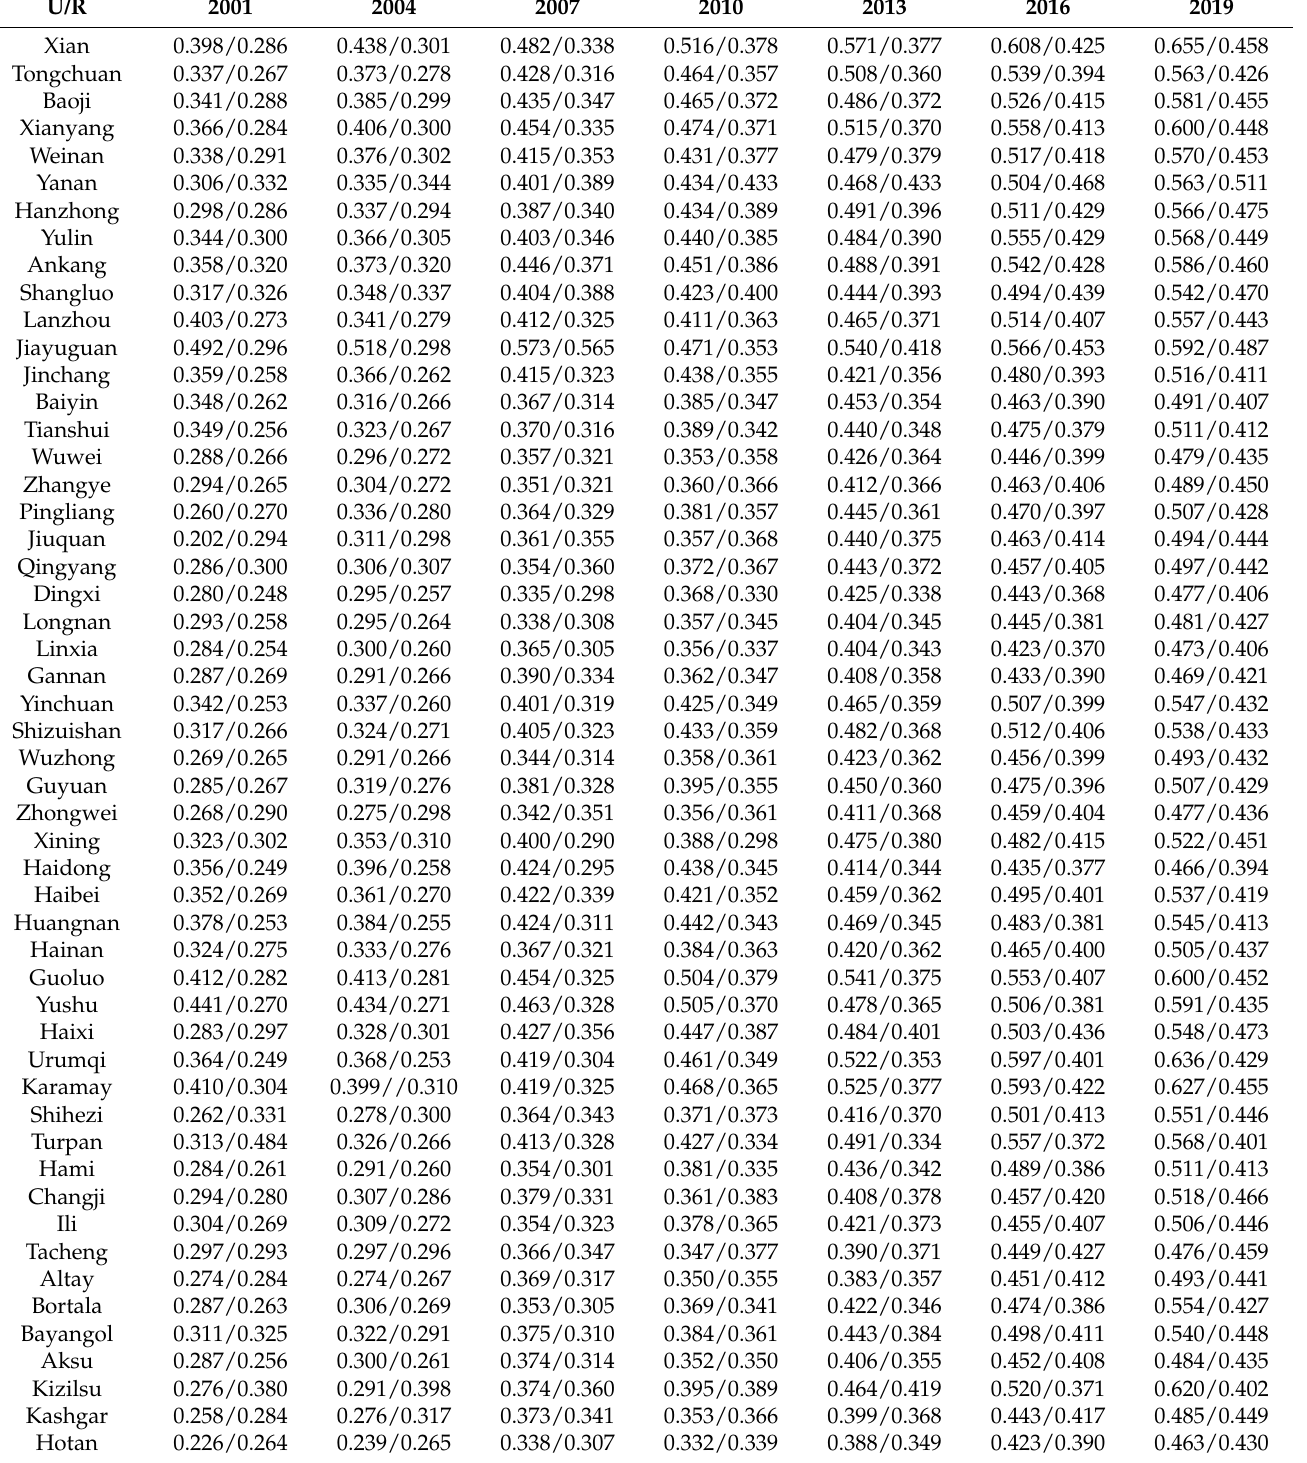
Table 3. Urban and rural water shortage risk values in northwest China from 2001 to